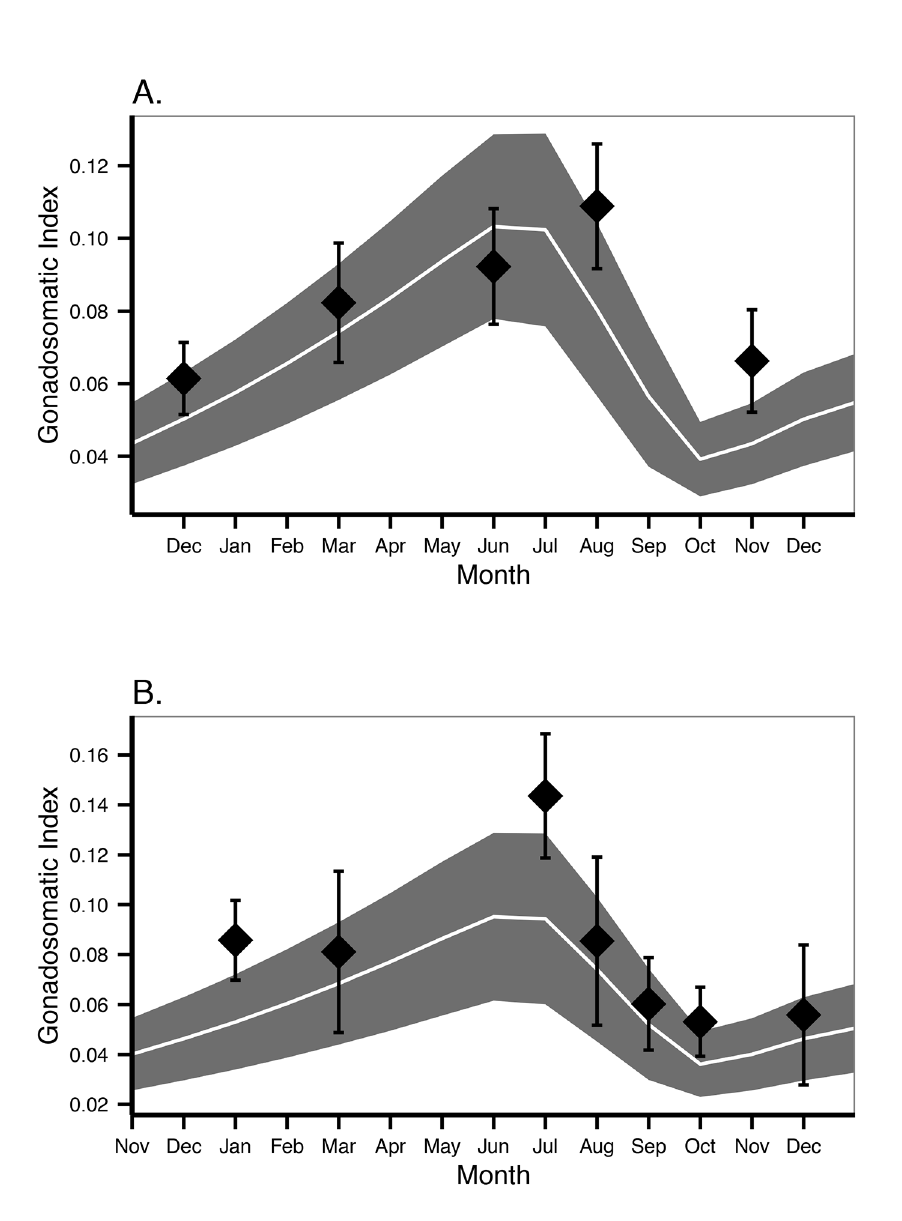
Fig 10. Gonadosomatic Index (GSI). A. Animals kept in the laboratory and fed ad libitum . B. Animals at the food level estimated for McMurdo. Points are mean and 95% confidence interval of laboratory and field observations respectively [25]. Line (mean) and shaded areas (95% confidence interval) are DEB model output applying the reproduction buffer handling rules to a 100 individuals with the same mean weight and SD than the ones used in the